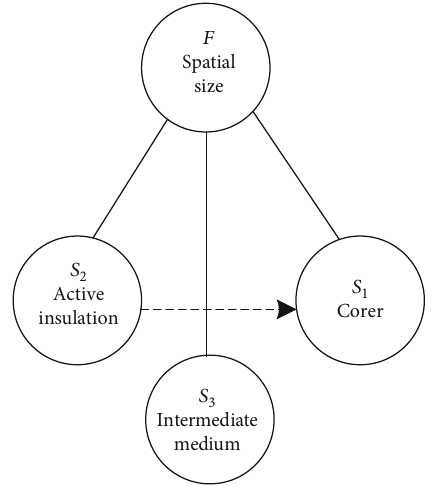
Figure 5: The improved material fi eld model of the active heat preservation